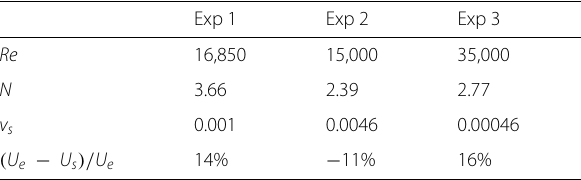
Data from Snow and Sutherland (2014). The experimentally measured and numerically computed front velocities are denoted as U e and U s